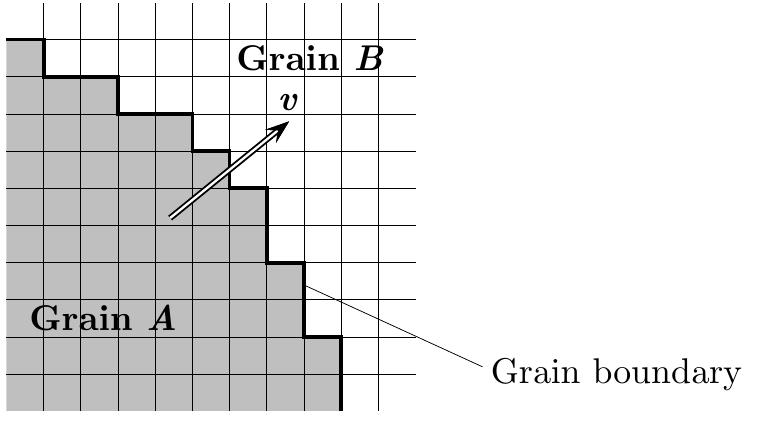
Figure 4. Schematic close-up of a grain boundary between two grains A and B in the cellular automaton. The cells belonging to grain A are shaded gray while the cells in grain B are white. The local boundary velocity v is